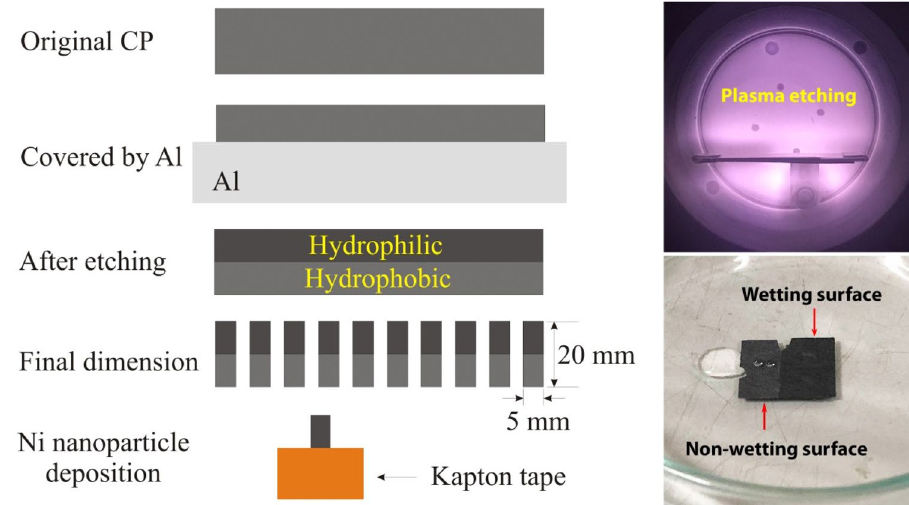
Fig. 1 Left: Illustration of the electrode preparation. Upper right: carbon papers under plasma etching. Lower right: Wetting test for the etched and non-etched CP surfaces by drooping water